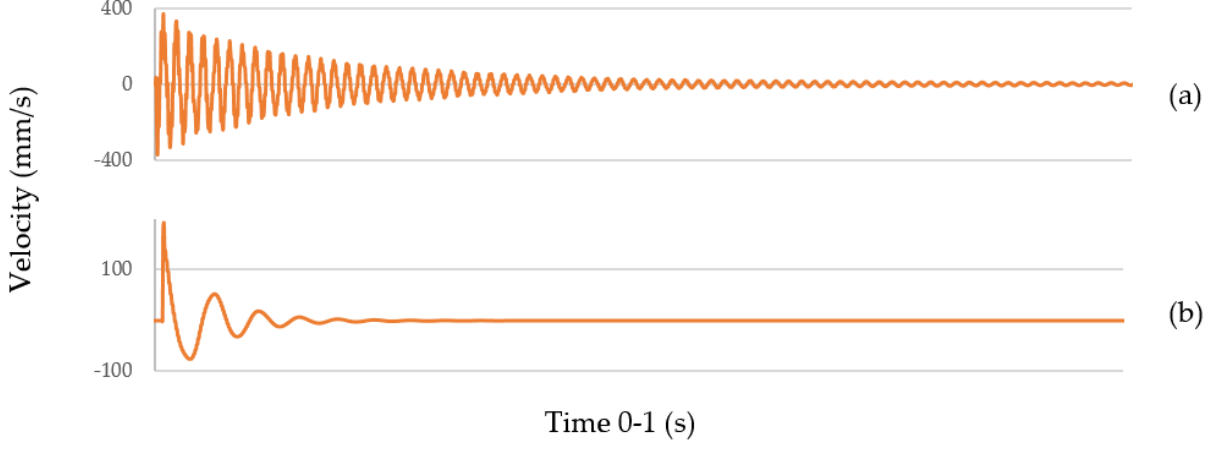
Figure 10. Time decaying curves of ( a ) steel and ( b ) polymer particle composite.